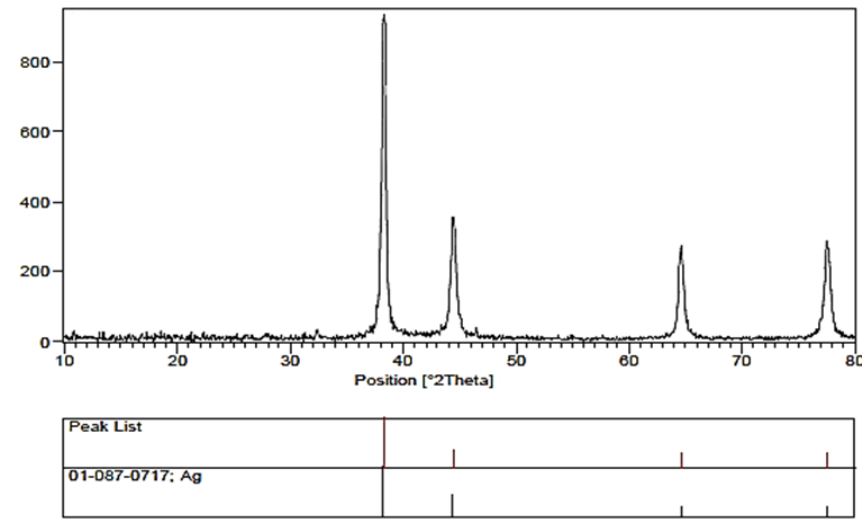
Fig. 2. XRD of Ag nanostructures